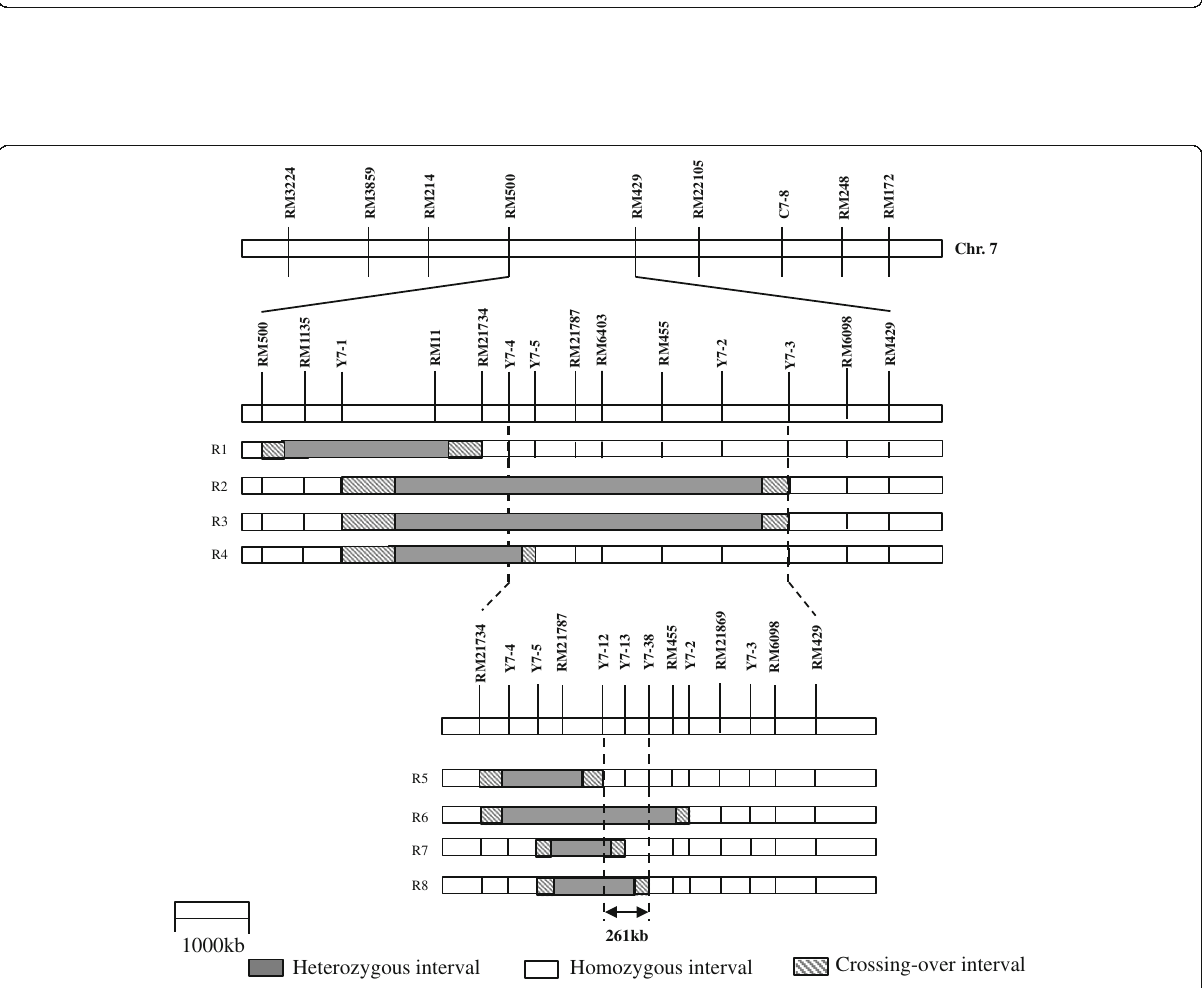
Fig. 4 Genotypes compositions of NIL populations in the target region. NIL, near-isogenic